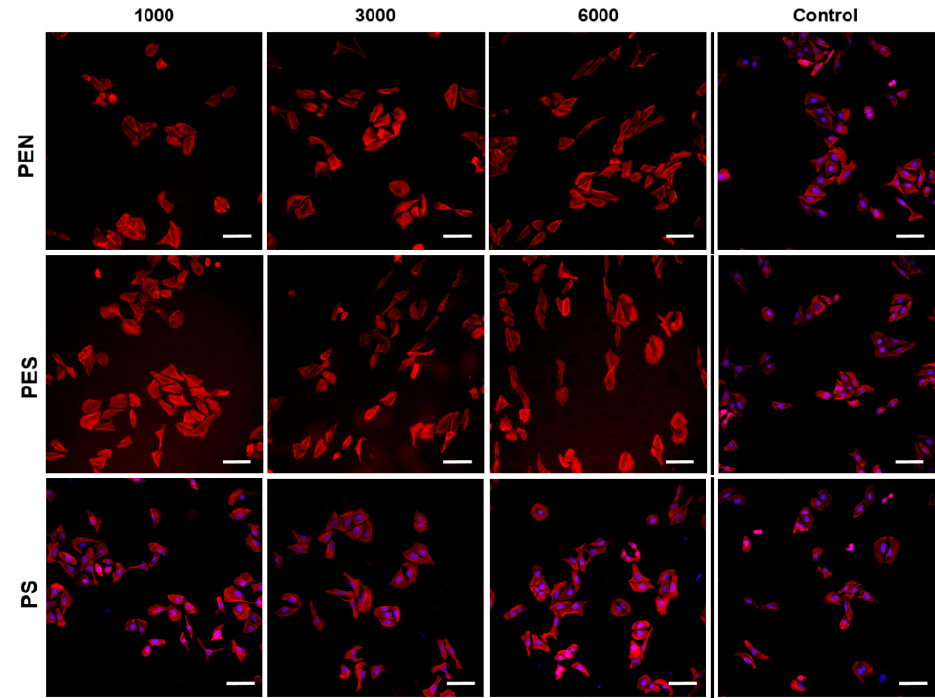
Figure 8. Fluorescence microscopy images of U-2 OS cells (human cells derived from osteosarcoma) growing on laser-treated PEN, PES, and PS with the fluence of 10 mJ·cm − 2 and 1000, 3000, and 6000 pulses. The photos were acquired 24 h post-seeding. As a control, tissue culture polystyrene (TCPS) was used. The white line represents 20 μ m.